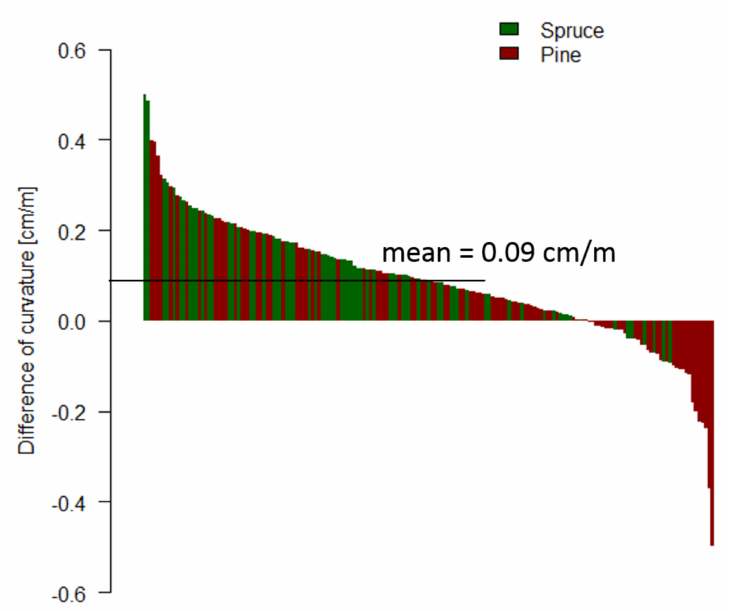
Figure A1. Differences of curvature values (contour algorithm-manual measurement) for a total of 179 logs of the species spruce and pine. Each bar represents one log.